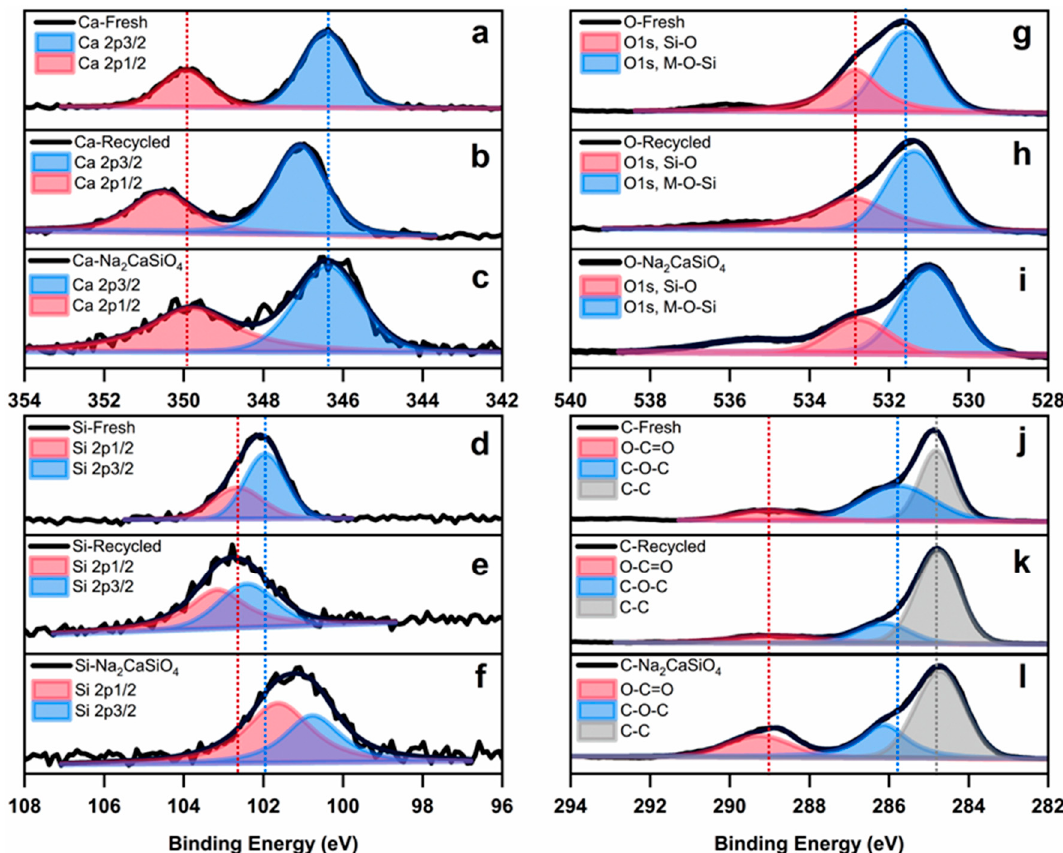
Figure 5. XPS analysis of the catalysts: ( a , d , g , j ) fresh NCSO; ( b , e , h , k ) recycled NCSO; ( c , f , i , l ) Na 2 CaSiO 4 .